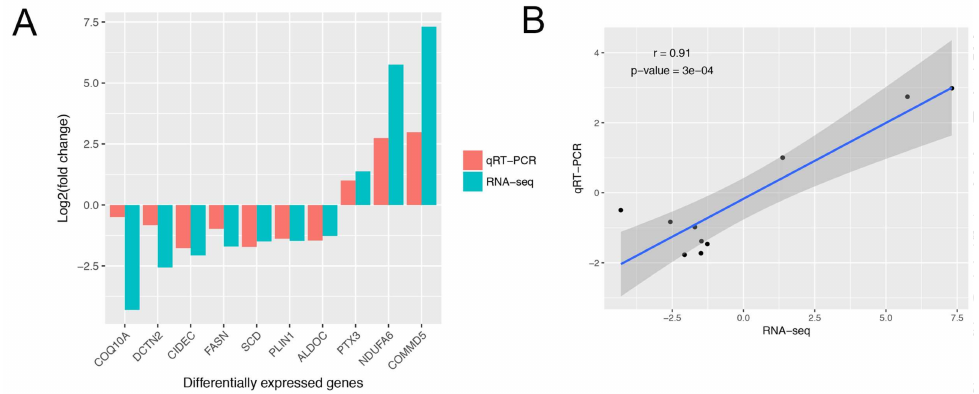
Figure 2. Real time quantitative reverse-transcription polymerase chain reaction (qRT-PCR) validation of differentially expressed genes (DEGs) and correlation with RNA sequencing (RNA-Seq). ( A ) Validation of the DEGs by qRT-PCR ( n = 3). The x axis represents DEGs and the y axis represents the log2 (L/H) for qRT-PCR and RNA-Seq; ( B ) Correlation analysis of DEGs between qRT-PCR and RNA-Seq. The x and y axes represent the log2 (L/H) measured by RNA-Seq and qRT-PCR, respectively.